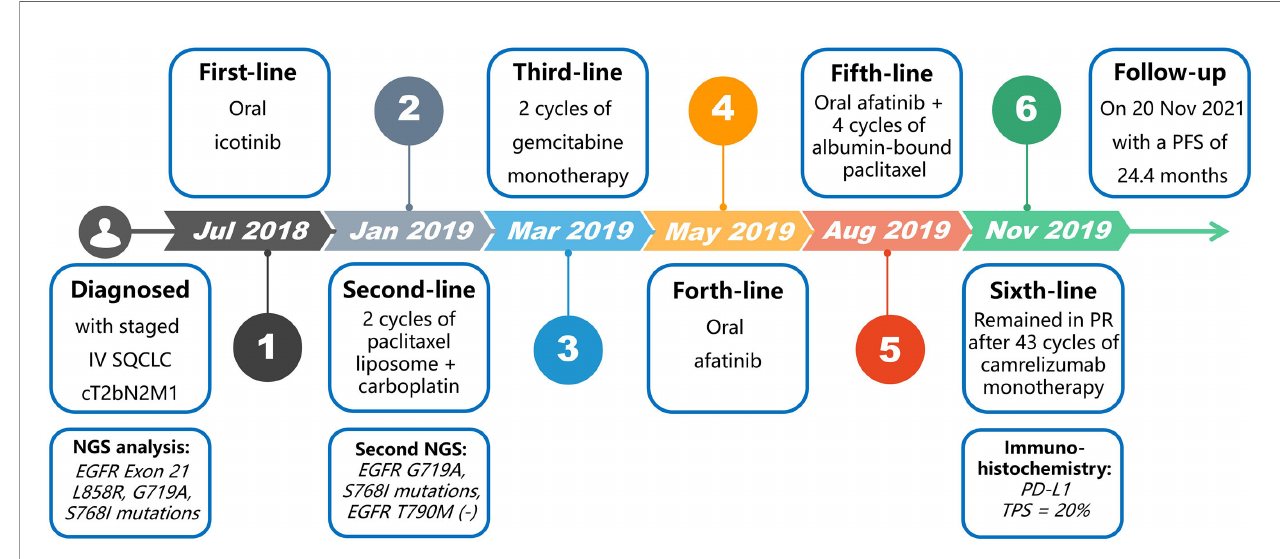
FIGURE 2 | Diagnosis and treatment